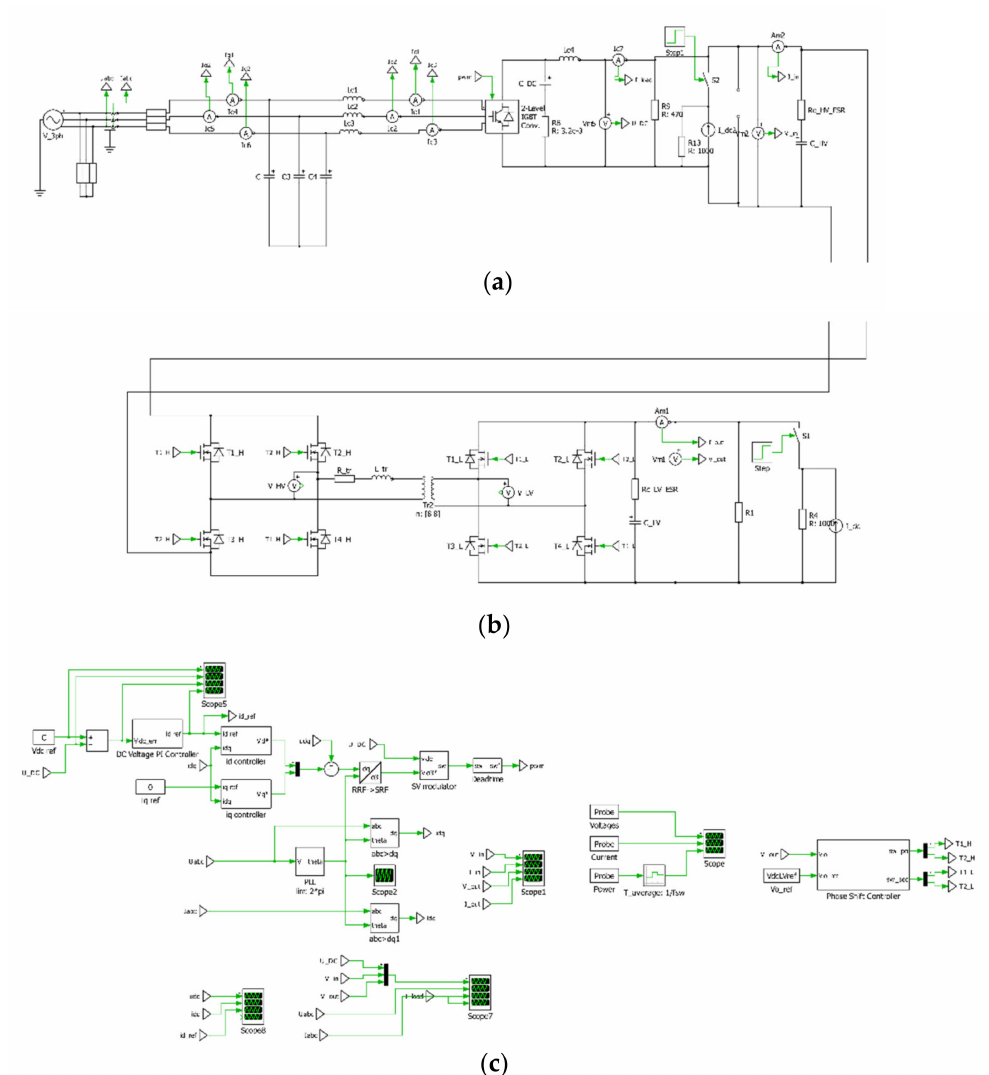
Figure 9. Developed in the PLECS environment, a simulation model of direct-current fast charger composed of: ( a ) 2-level AC/DC converter module; ( b ) DC/DC DAB converter module; ( c ) control algorithms: VOC control for AC/DC converter and a Phase Shift Controller for the DC/DC